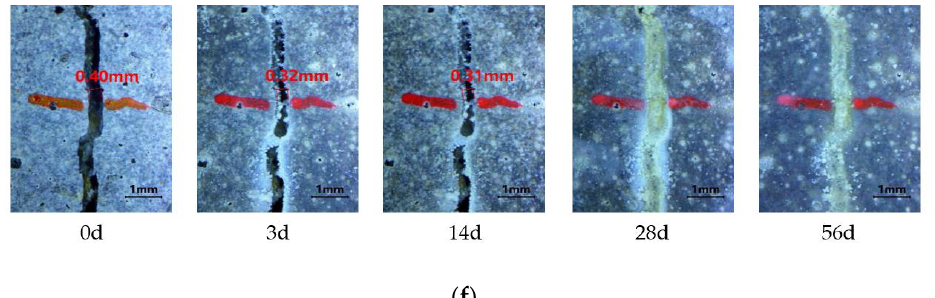
Figure 2. Self-healing images of surface crack in mortars under different exposure environments. ( a ) The control mortar specimens under the standard curing. ( b ) Mortar specimens with bacteria under the standard curing. ( c ) The control mortar specimens under the dry – wet cycle curing. ( d ) Mortar specimens with bacteria under the dry – wet cycle curing. ( e ) The control mortar specimens under the water curing. ( f ) Mortar specimens with bacteria under the water curing.